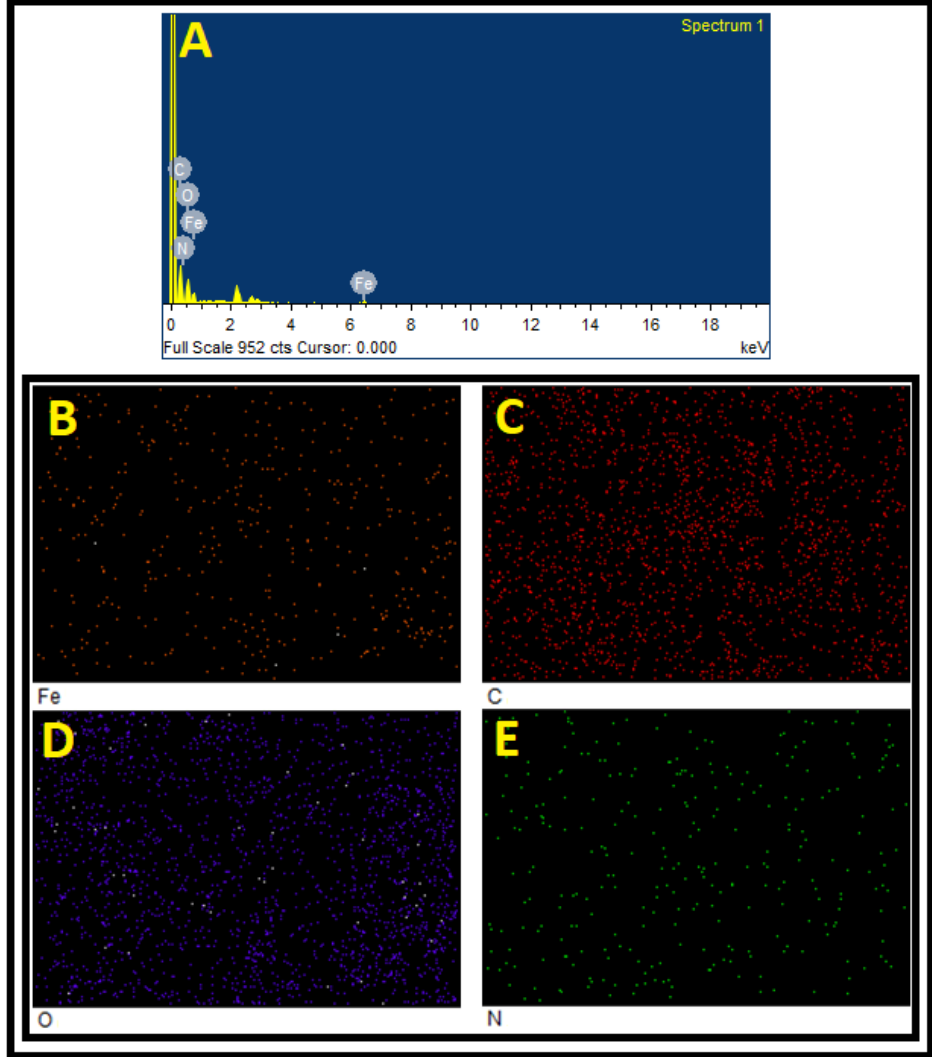
Figure 6. EDS analysis of MIL-101(Fe). ( A ) EDS Spectra; ( B ) EDS of iron; ( C ) EDS of Carbon; ( D ) EDS of Oxygen; ( E ) EDS of Nitrogen.